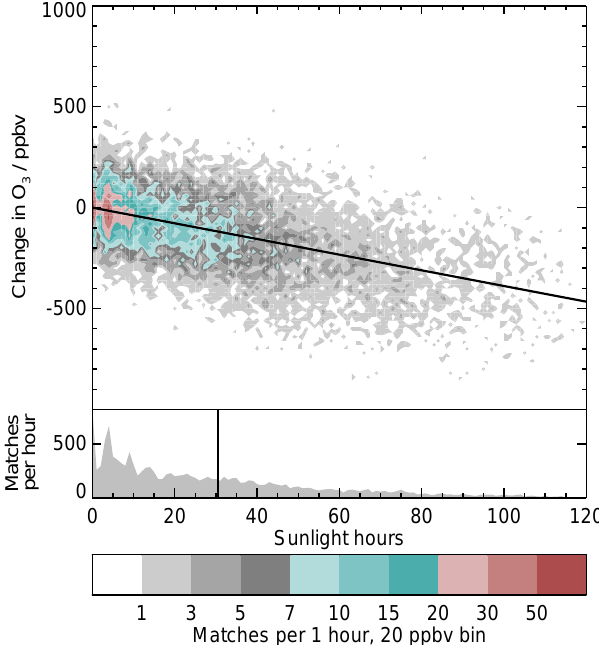
Figure 1. Two-dimensional histogram of change in O 3 abundance vs. elapsed time in sunlight for ∼ 15000 matched MLS observa- tions in a 25K-thick window centered at 450K potential tempera- ture ( ∼ 70hPa, ∼ 18km) between 15 February and 1 March 2005. White indicates no values in a given bin; grays, cyans and reds in- dicate increasingly large populations. The sloping black line shows the fitted loss rate estimate of 3.9ppbv per sunlight hour. The lower panel shows a histogram of the sunlight exposure times for the air masses between the matched observations, with a black vertical line denoting the mean of ∼